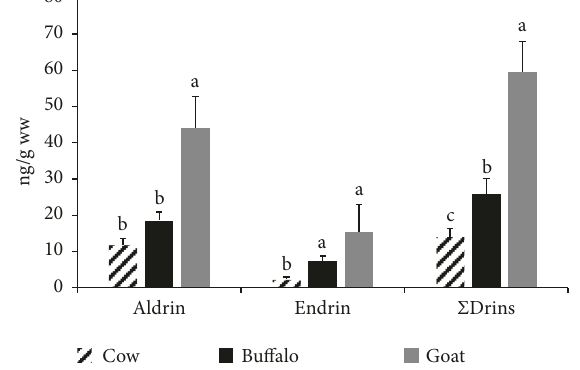
Figure 6: Total drins in the examined milk samples. Data represent mean ± SE (ng/g ww) for total drins in the examined milk samples from different animal species (n=20 each). Columns that carry same superscript letter among the same chemical are not significantly different at p < 0.05.